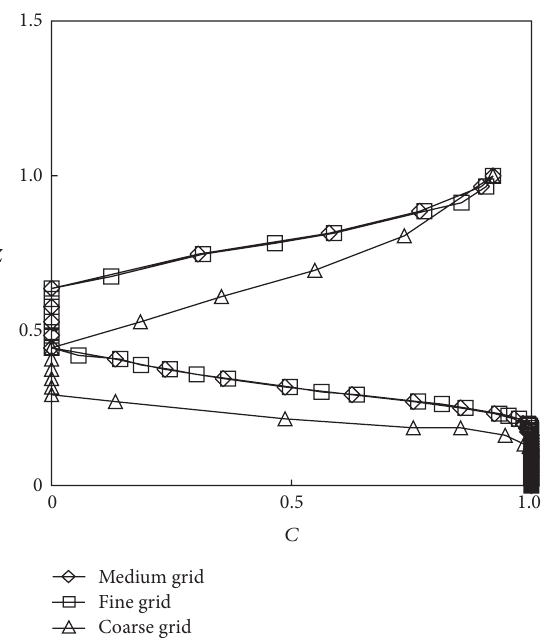
Figure 5: Check of grid independence (at location 𝑥 =